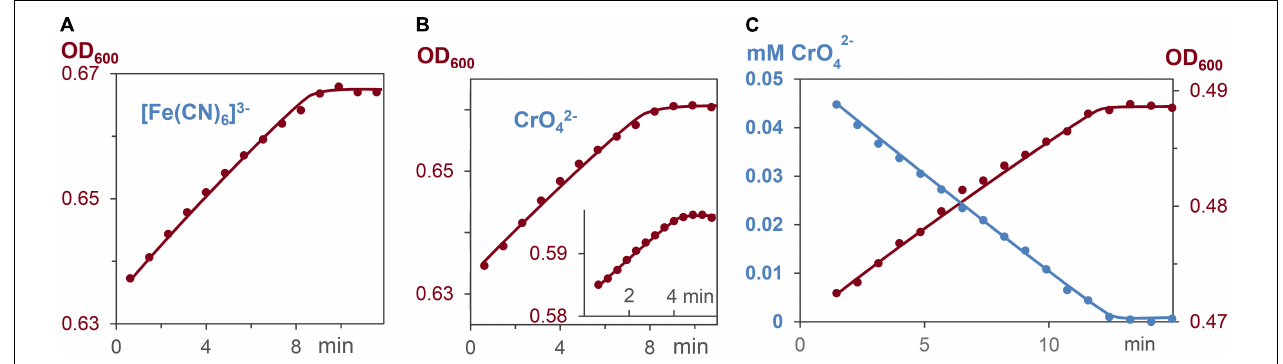
FIGURE 6 | Increase of cell concentration and decrease of oxidants [Fe(CN) 6 ] 3 − and CrO 42 − during G. sulfurreducens respiration in grow medium A, lacking fumarate, and stating from the lag phase. (A) Linear increase of the bacterial growth with 0.15 mM [Fe(CN) 6 ] 3 − , R 2 = 0.98. (B) Linear increase of the bacterial growth with 0.05 and 0.03 mM CrO 42 − (insert), R 2 = 0.98. (C) Linear CrO 42 − decrease (blue, R 2 = 0.99), and linear bacterial growth (brown, R 2 = 0.98) of the same respiration